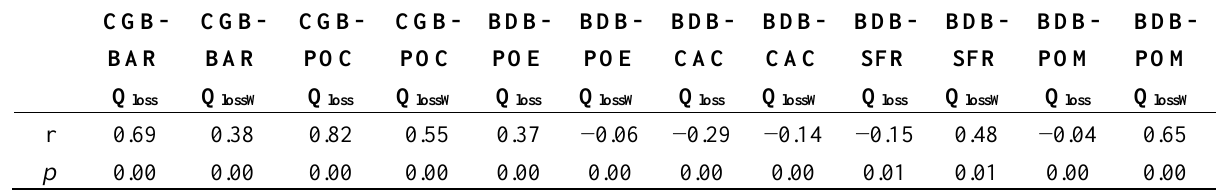
Table 7. Correlation coefficients (r) between annual discharge loss (Q loss ) or wet season discharge loss (Q lossW ) and simulated actual evaporation (AET) for the study area and their p -values for considered Hidroweb stations from ANA ( Agência Nacional de Águas : National Water Agency in Brazil) in the study area (Figure